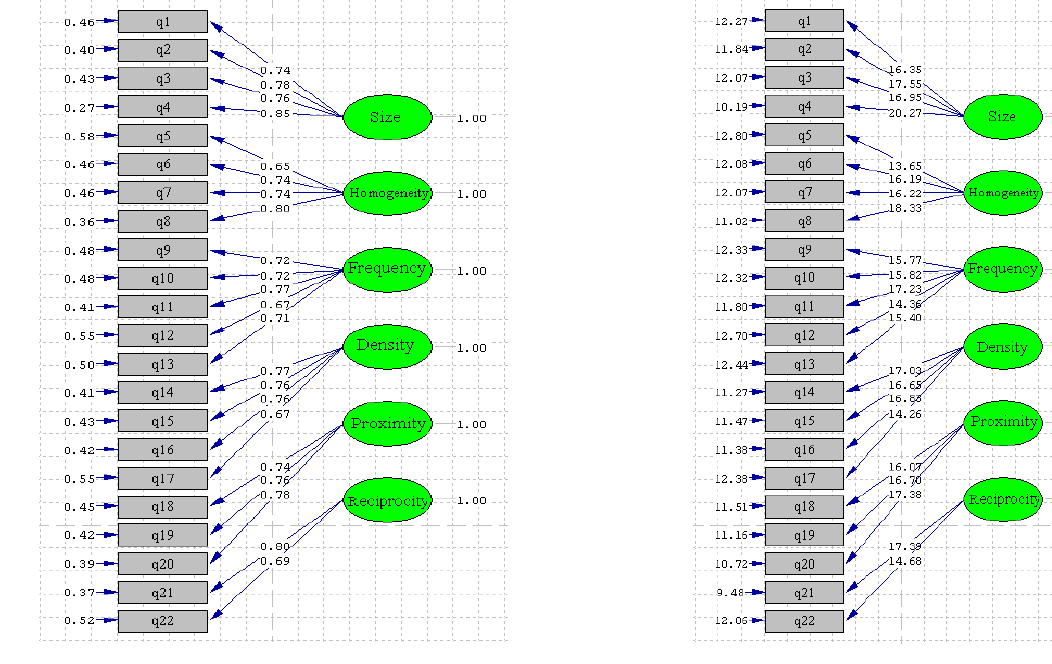
Fig. 2. The results of first order standard coefficients and t-values